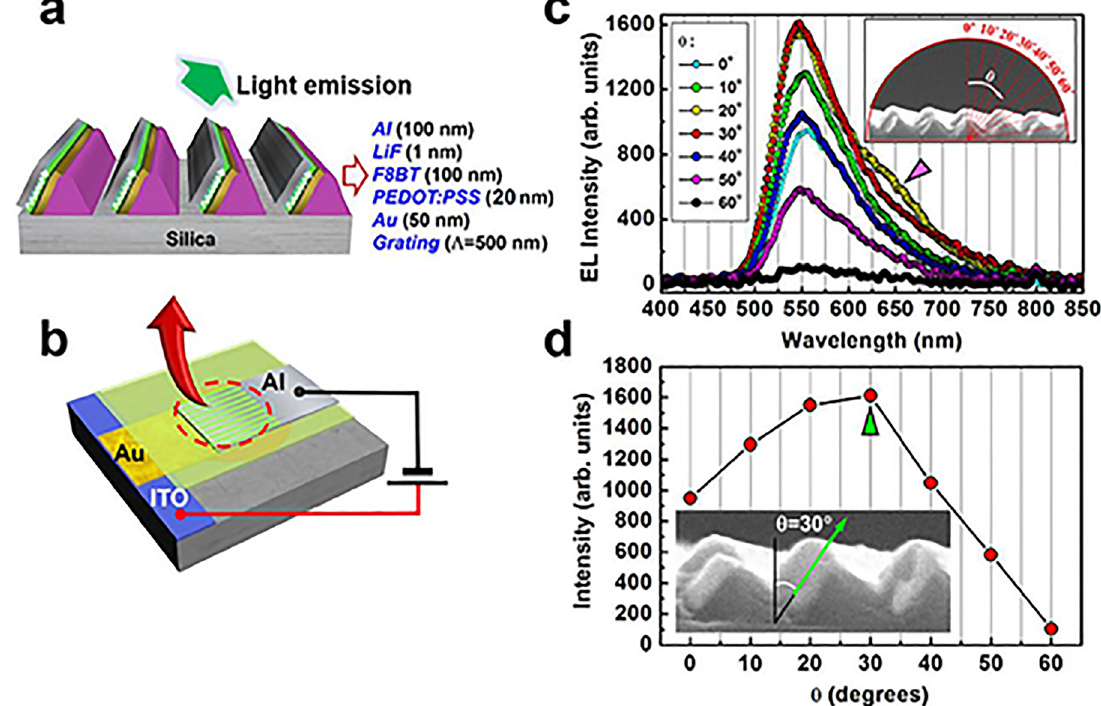
Figure 2: (a) Schematic illustration of the nanoOLEDdevices for directional end emitting with a periodical arrangement on the side walls of the gratinglines.(b)Thestructuraldesignandelectroluminescence(EL)measurementschemeforthenanoOLEDarray.(c)TheELspectraatdifferent emissionanglesfrom0to60degrees.Inset:definitionoftheemissionangle( θ ).(d)Spectralintensityofelectroluminescenceasafunctionofthe emission